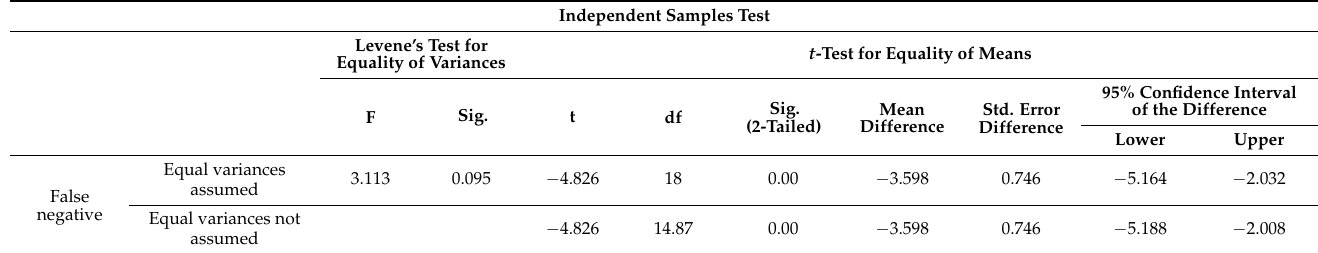
Table 12. Comparison of independent sample t -test parameters of the EDRL and CNN algorithms for the false